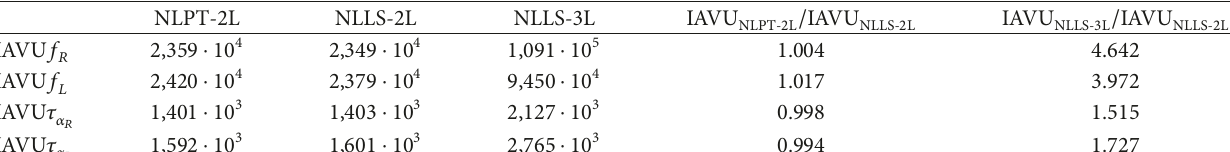
Table 5: IAVU index comparison between NLPT-2L, NLLS-2L, and NLLS-3L.